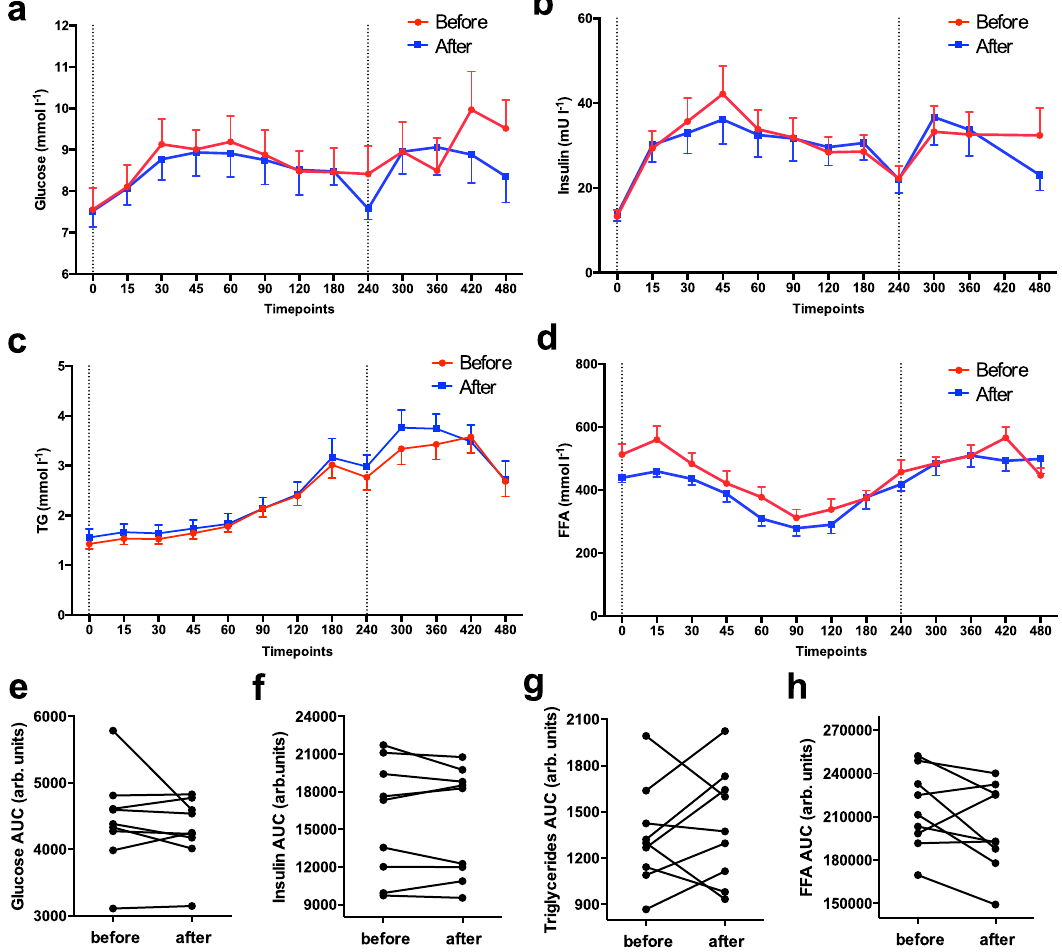
Fig. 2 Plasma levels during the meal tests. a Plasma levels of glucose ( n = 9). b Insulin ( n = 9). c Triglycerides ( n = 9). d Free fatty acids during the meal test ( n = 9). e – h Corresponding area under the curves (AUC) ( n = 9). Before mild cold acclimation is presented as the red line, after mild cold acclimation as the blue line. Dashed vertical lines indicate the time of consumption of the 1st shake at T0 and the 2nd shake at T240. Data was analyzed with a two-sided Wilcoxon matched-pairs signed rank test. No signi fi cant differences were observed (all p >0.05). Data is presented as mean±SE and individual